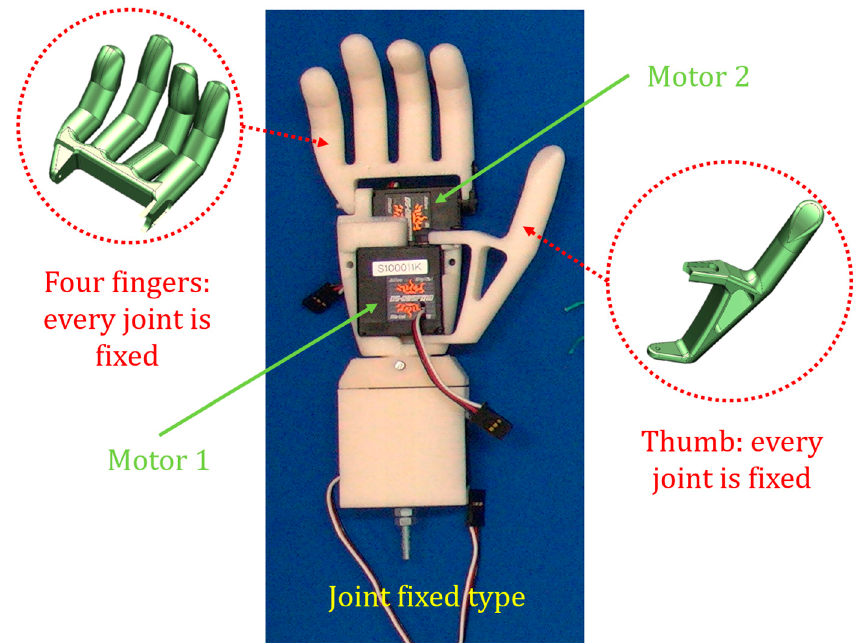
Figure 17. Joint fixed type: the assembled hand, parts of the four fingers, and thumb.